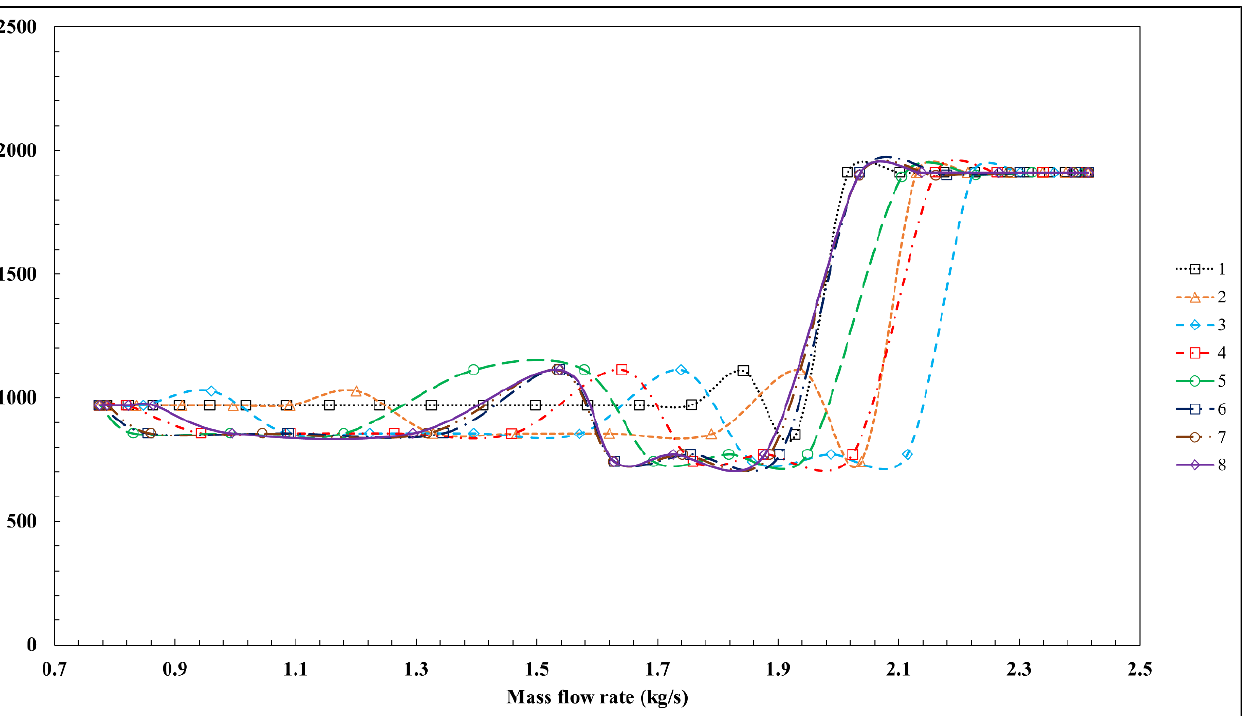
Figure 4. Frequency versus mass flow rate.